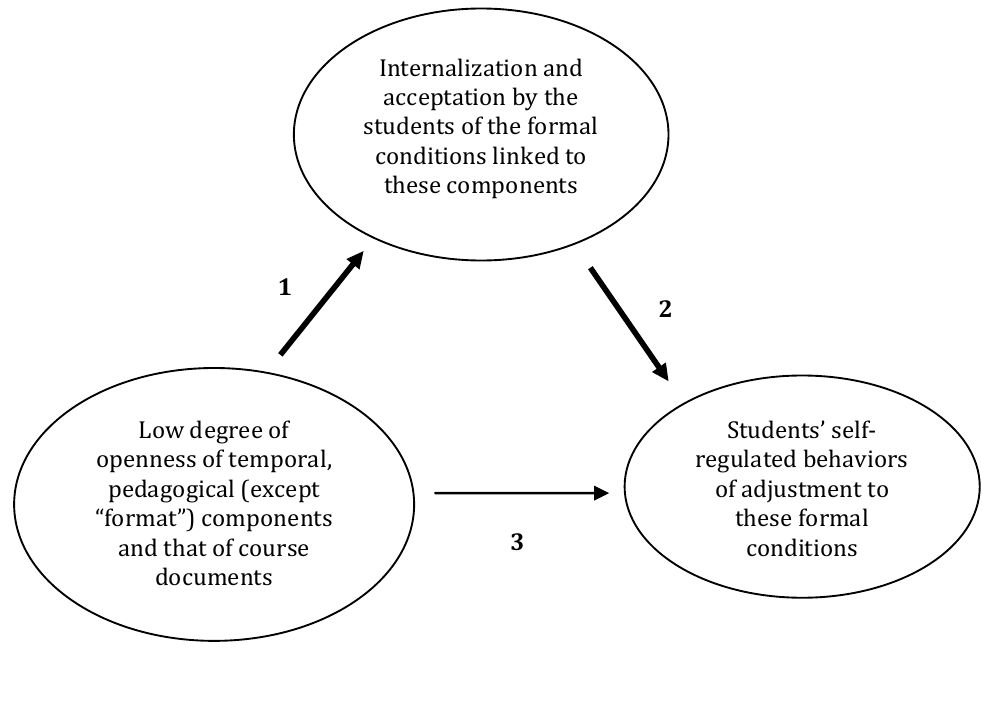
Figure 7 . The mediated role of internalization and acceptance by the students of formal conditions linked the eleven components with a low degree of